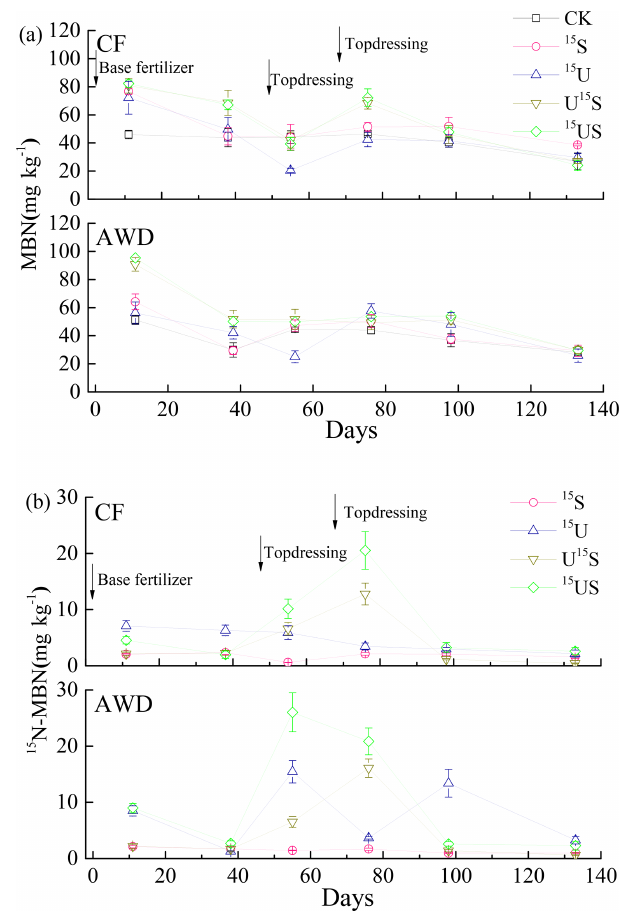
Figure 3. Changes in the concentration of microbial biomass N (MBN) (a) in the soil during the growth period of rice and the con- tribution of 15 N markers to MBN (b) ( n = 3).